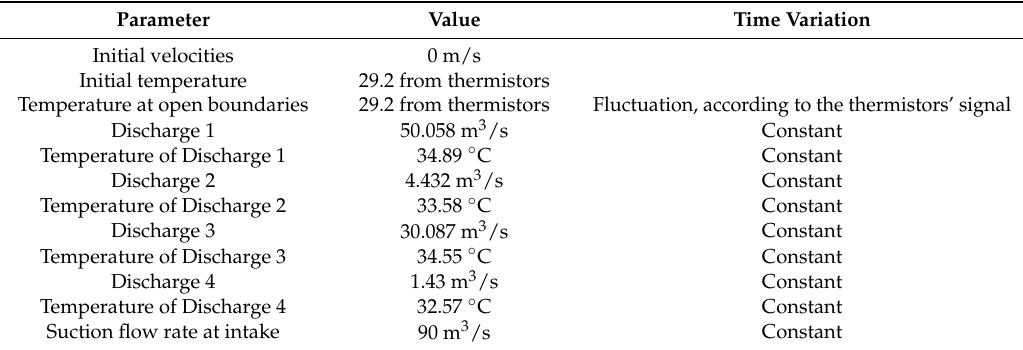
Table 1. Initial conditions and physical parameters used for the numerical